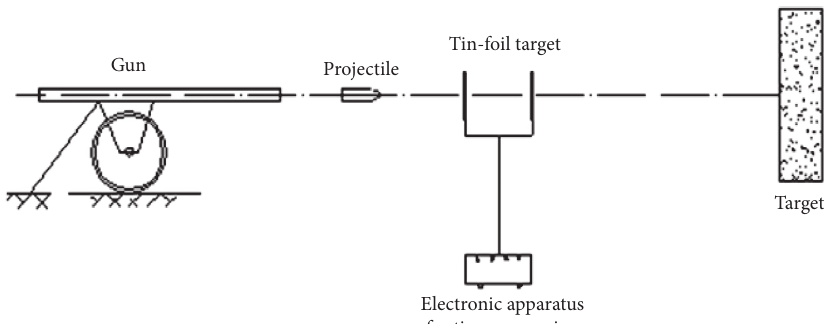
Figure 4: Test arrangement diagram.